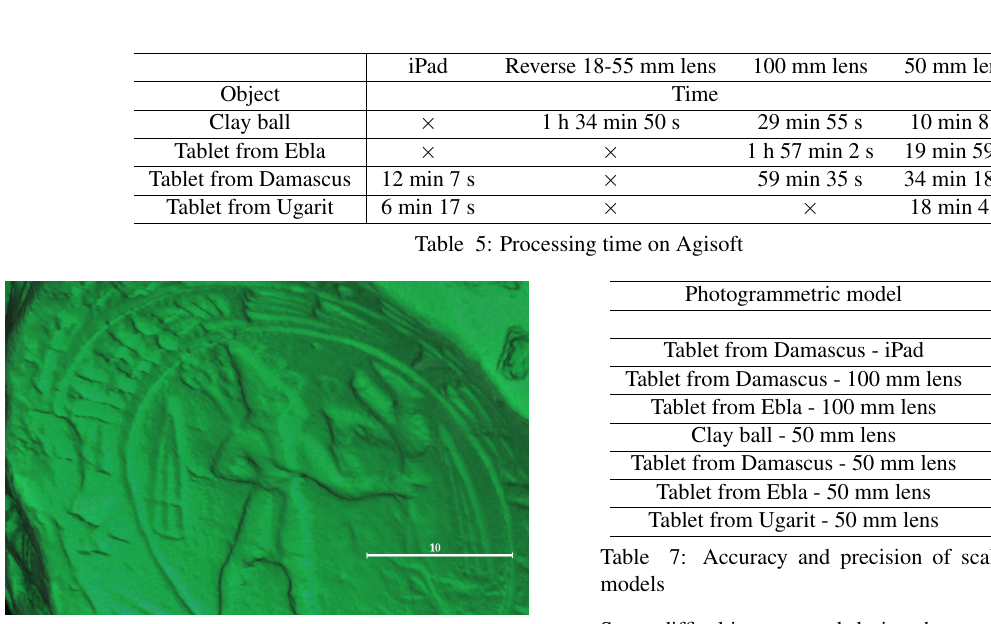
Figure 6: Small detail of the laser scanner 3D model of the tablet from Damascus (scale in millimeters)